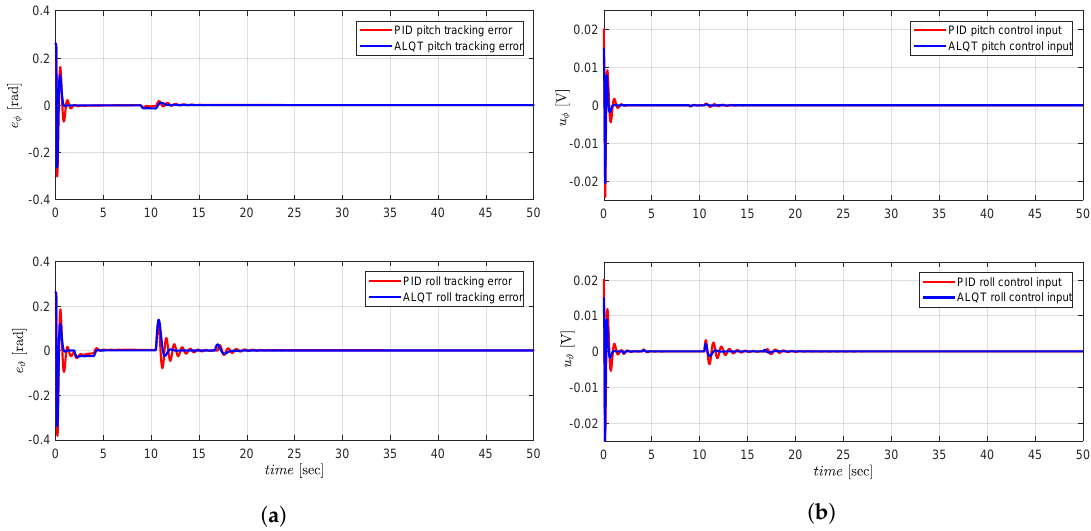
Figure 16. PID vs. ALQT performance comparison: ( a ) attitude tracking error; ( b ) attitude control